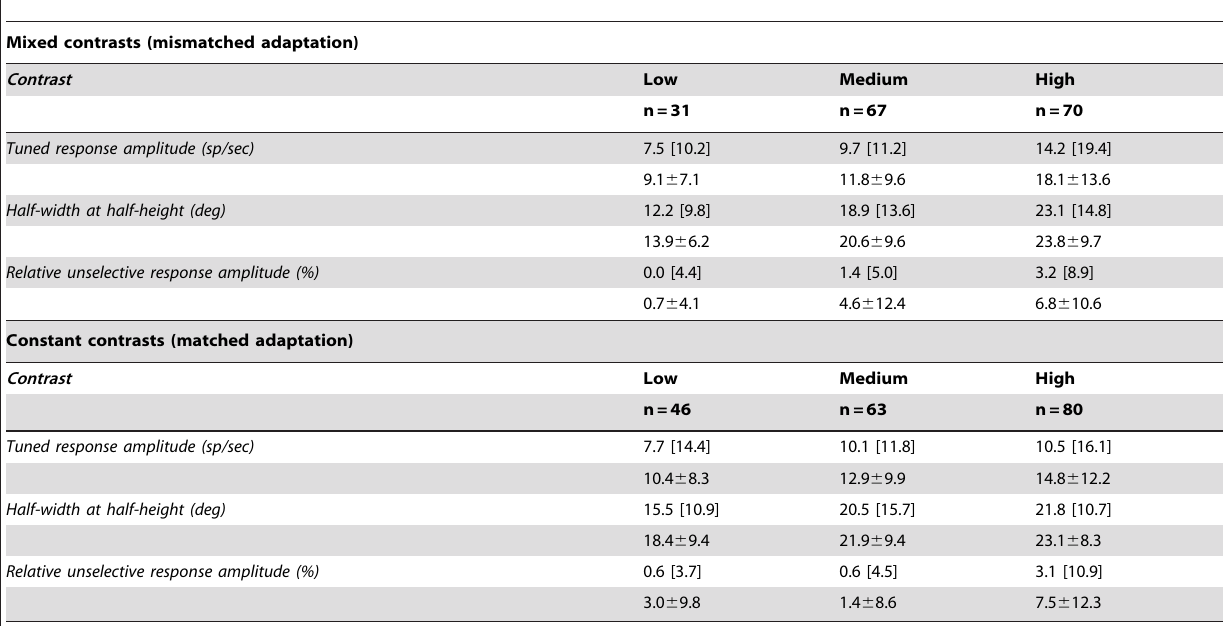
Table 1. Tuned response amplitude, half-width at half-height and relative untuned response amplitude at different contrasts, in mixed or constant contrasts